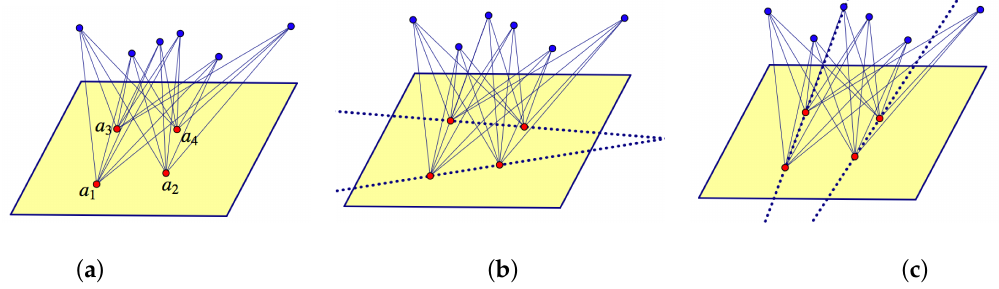
Figure 27. Given K 4,6 with a 1 , a 2 , a 3 , a 4 coplanar ( a ), there is a 2-space of conics generated for example by pairs of lines ( b , c